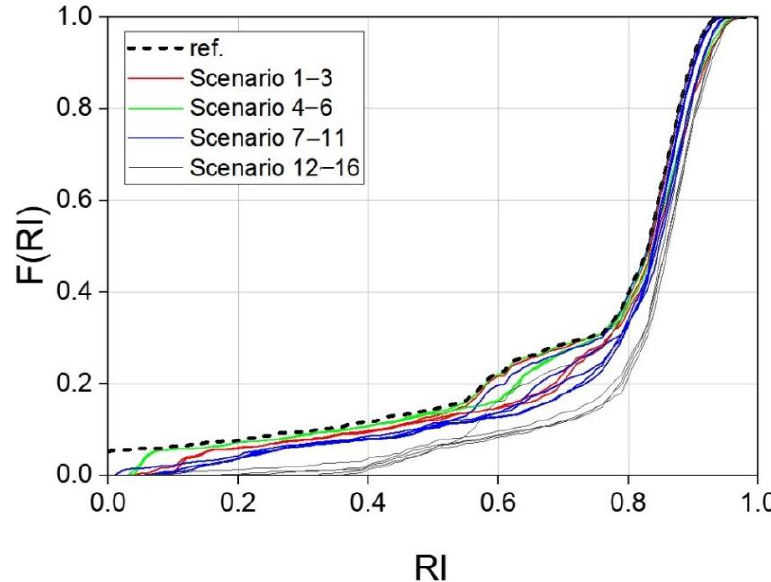
Figure 8. Results of E-CDF for various scenarios in failure of three facilities. Table 3. Results of EoRE.